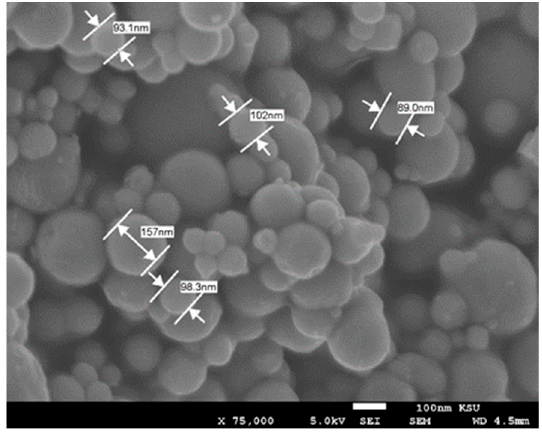
Figure 2. Sn Figure 2. Sn nanopowder. Figure 2. Sn nanopowder.